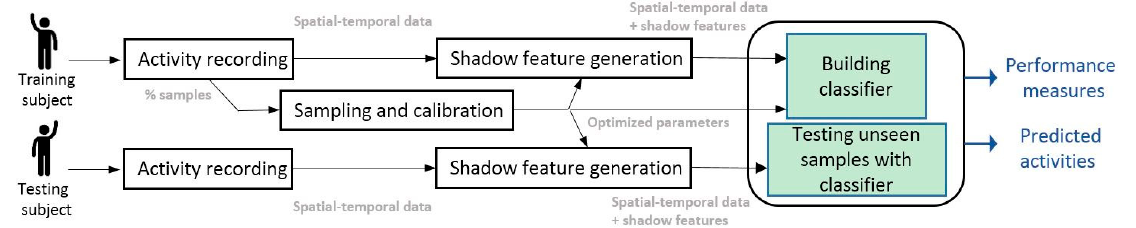
Figure 2. Proposed HAR classification model.